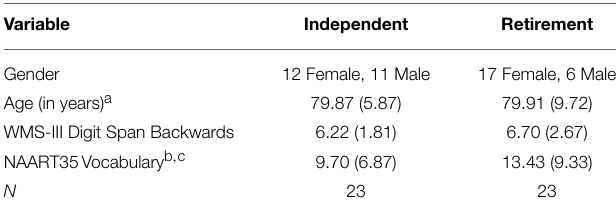
TABLE 1 | Mean values (with standard deviation in parentheses) of participant